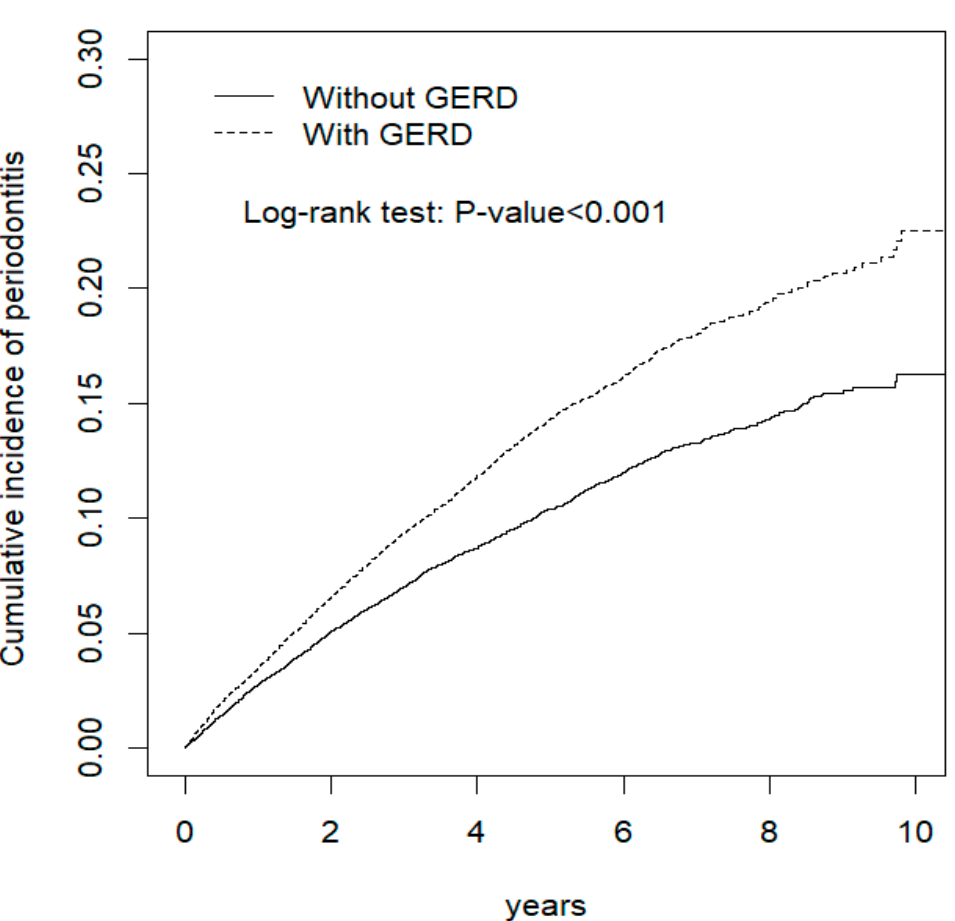
Figure 1. Cumulative incidence of periodontitis between individuals with and without gastroesophageal reflux disease (GERD). Patients with GERD had an increased cumulative risk of periodontitis as compared those without GERD. Table 2. Incidence rates and hazard ratios of periodontitis for all